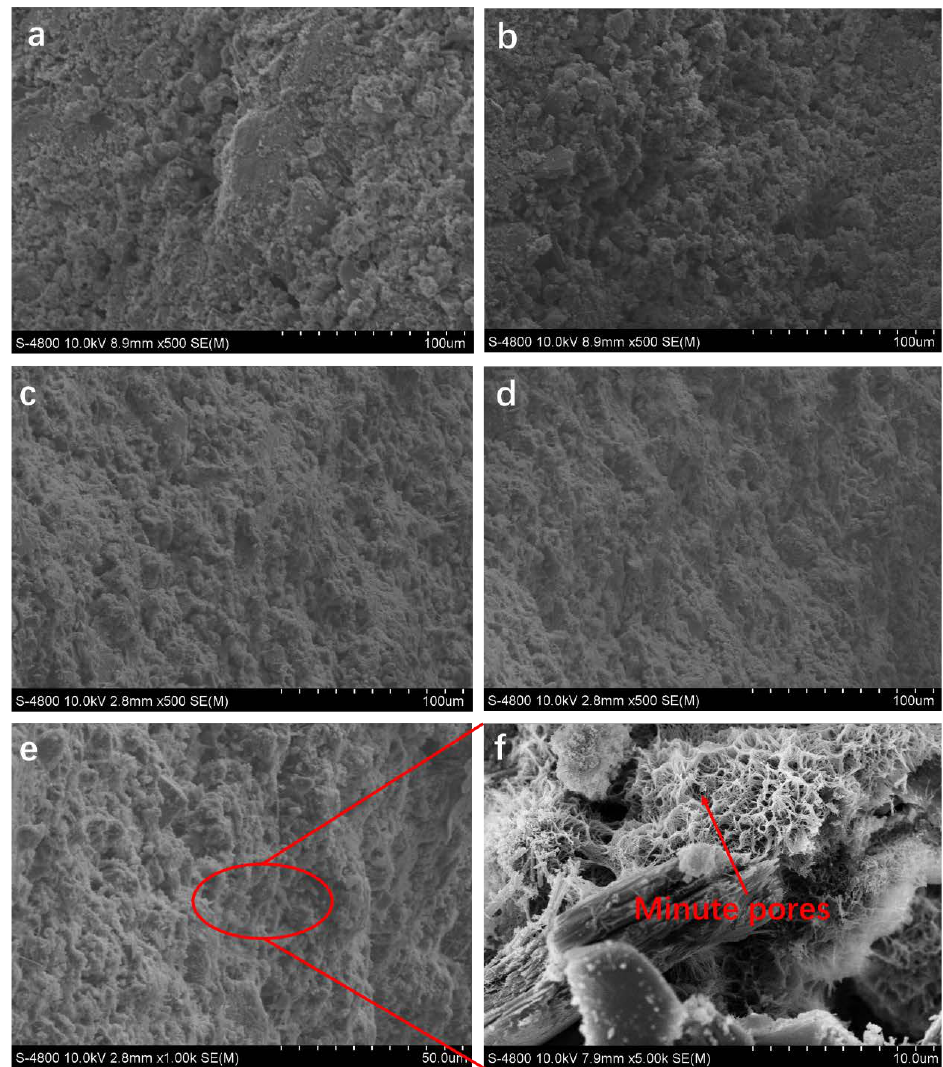
Figure 7. SEM images of the PSCM based on the hot–dry casting process at ( a ) 40 ° C, ( b ) 60 ° C, ( c ) 80 ° C, and ( d ) 100 ° C. ( e ) The surface of the pore structure and ( f ) its detail.